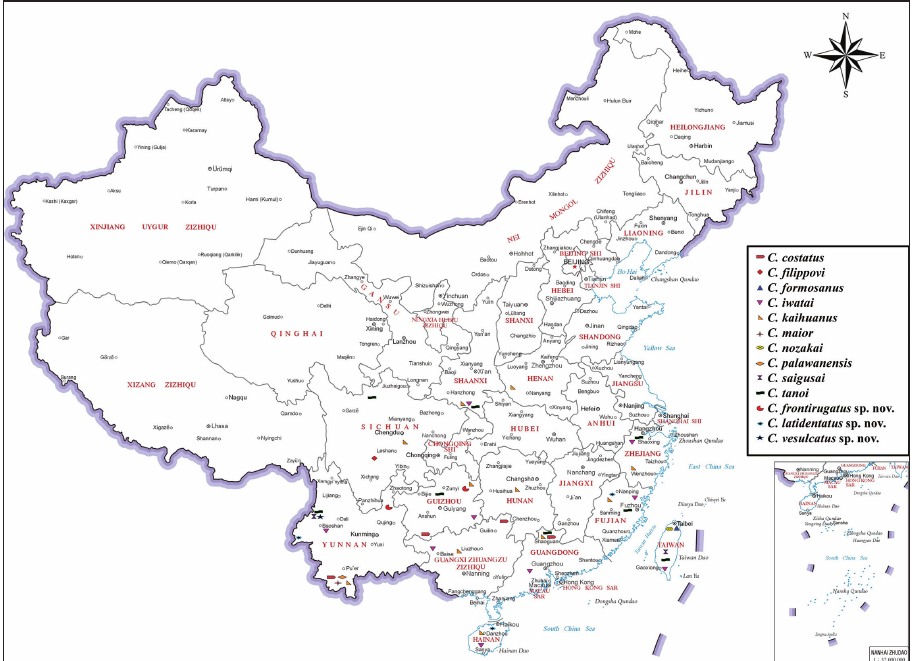
Figure 1. Distribution of Carinostigmus from